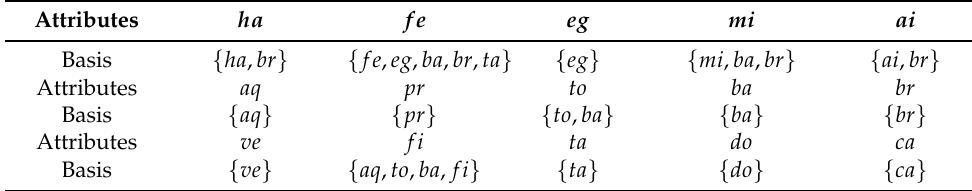
of Zoo database. B A